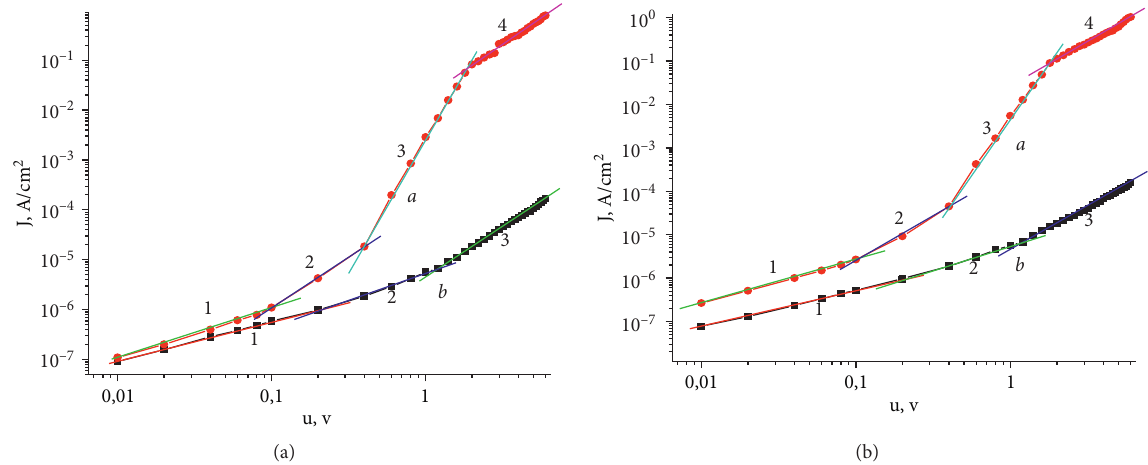
Figure 2: I-V characteristics of type I ∼ V α with different inclinations in the forward (a) and reverse (b) current directions up to I and after (II) UST. Ia: 1-1, 2-2, 3-5.3, 4-2; Ib: 1-0.84, 2-1, 3-2. IIa: 1-1, 2-2, 3-5, 4-2; IIb: 1-0.79, 2-1, 3-2.